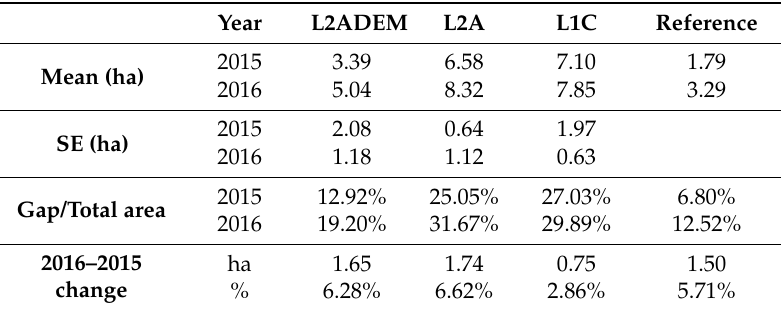
Table 5. Area evaluation results on